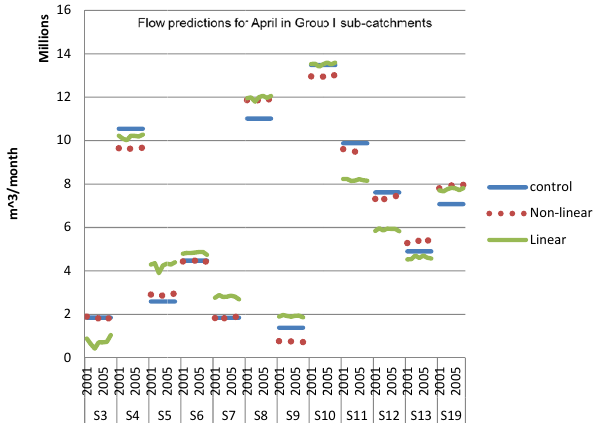
Table 6. Grouping of Semliki sub-catchments from the PCA.